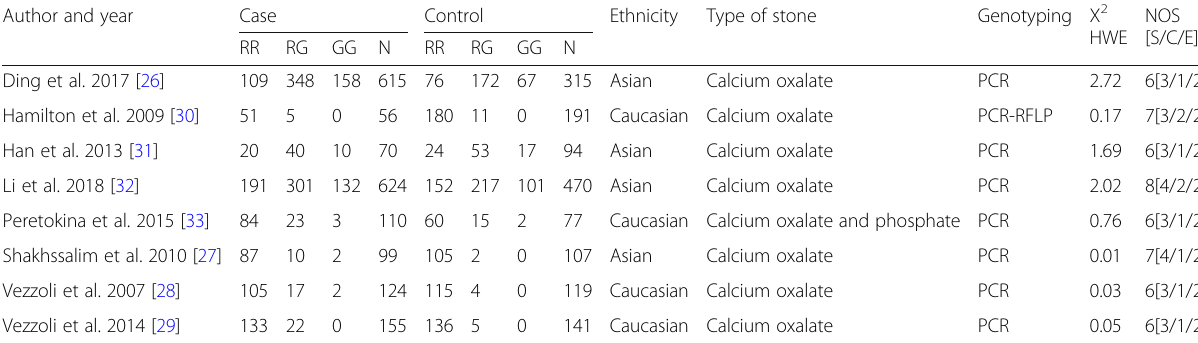
Table 1 Baseline characteristics of studies concerning CaSR R990G gene polymorphism in patients with urolithiasis included in the meta-analysis